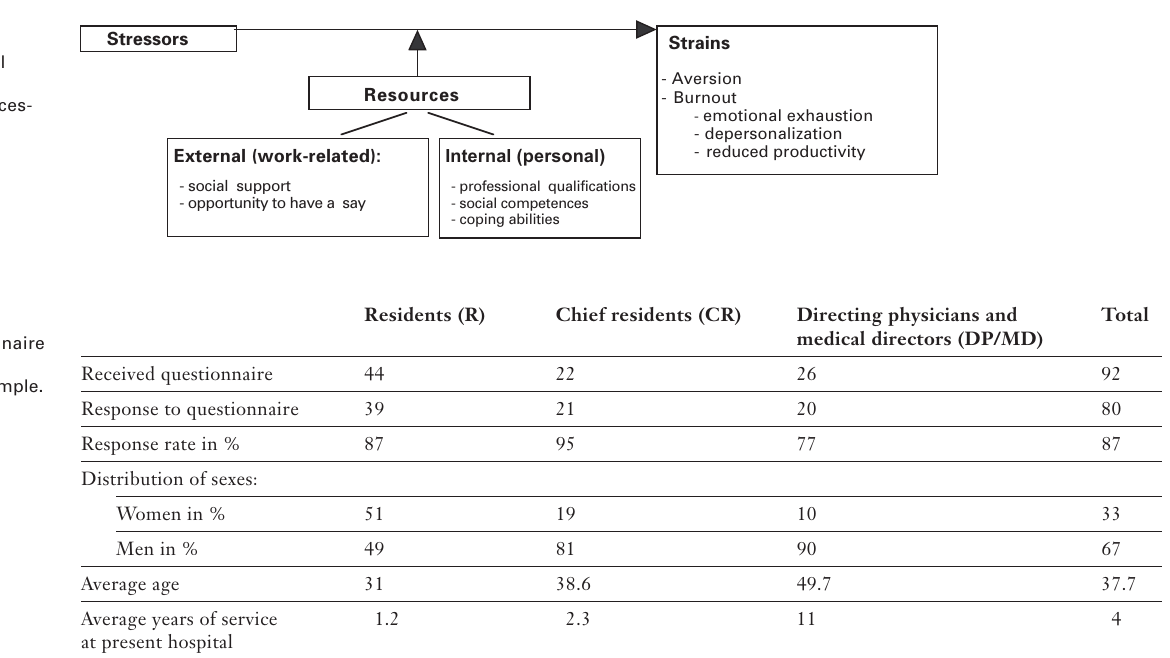
Written questionnaire respondents: description of sample.